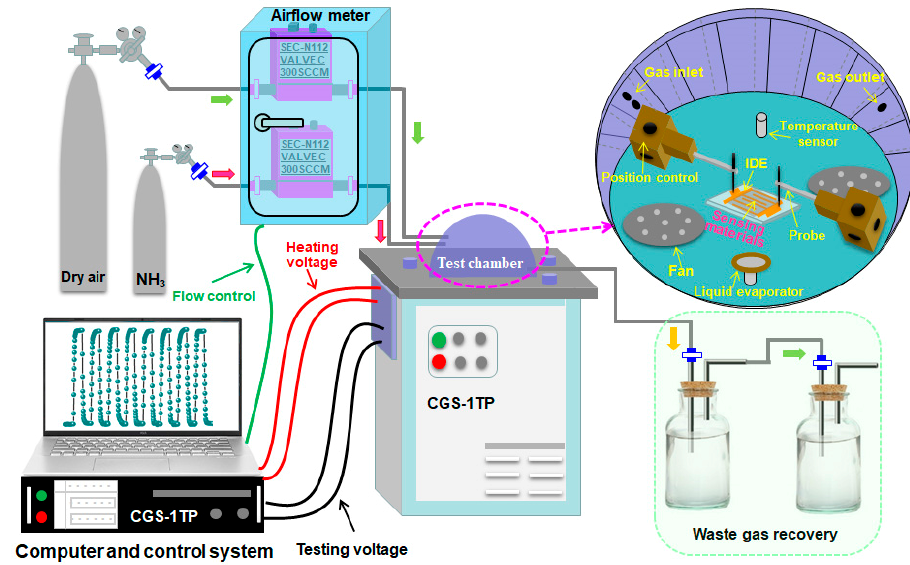
Figure 1. Schematic diagram of gas sensors testing system.